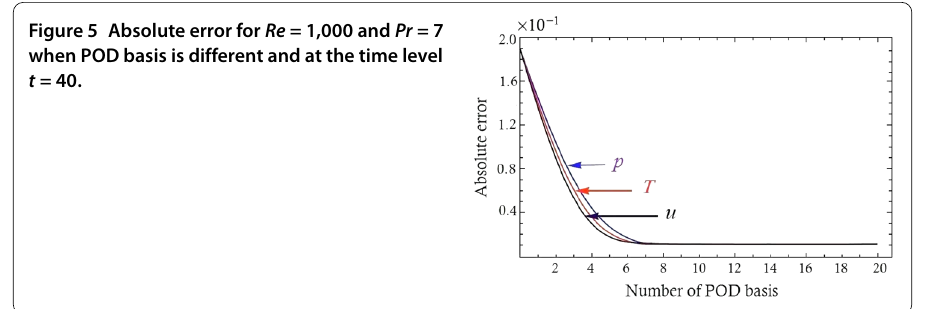
Figure 5 Absolute error for Re = 1,000 and Pr = 7 when POD basis is different and at the time level t =